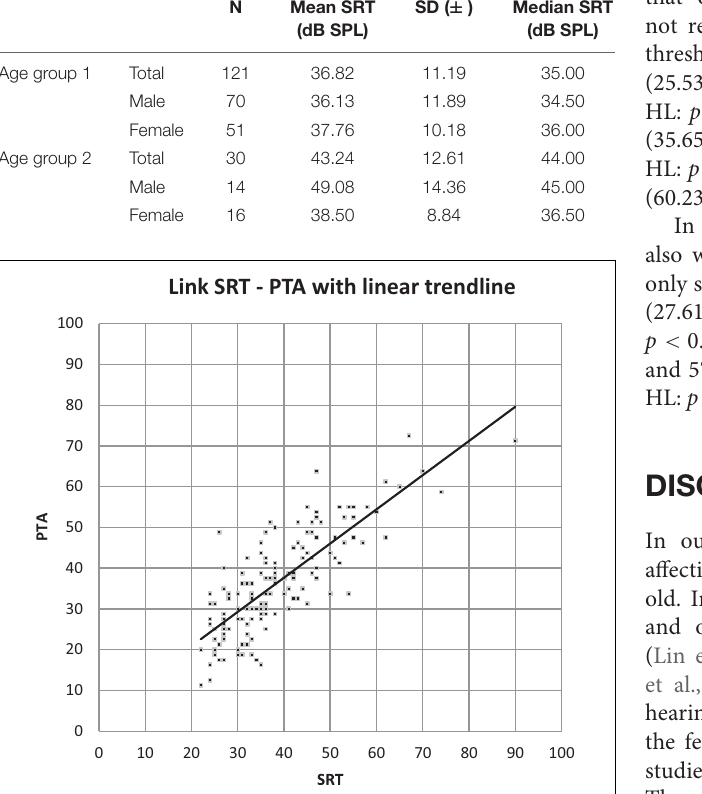
FIGURE 5 | The link between PTA and SRT with a linear trend line.